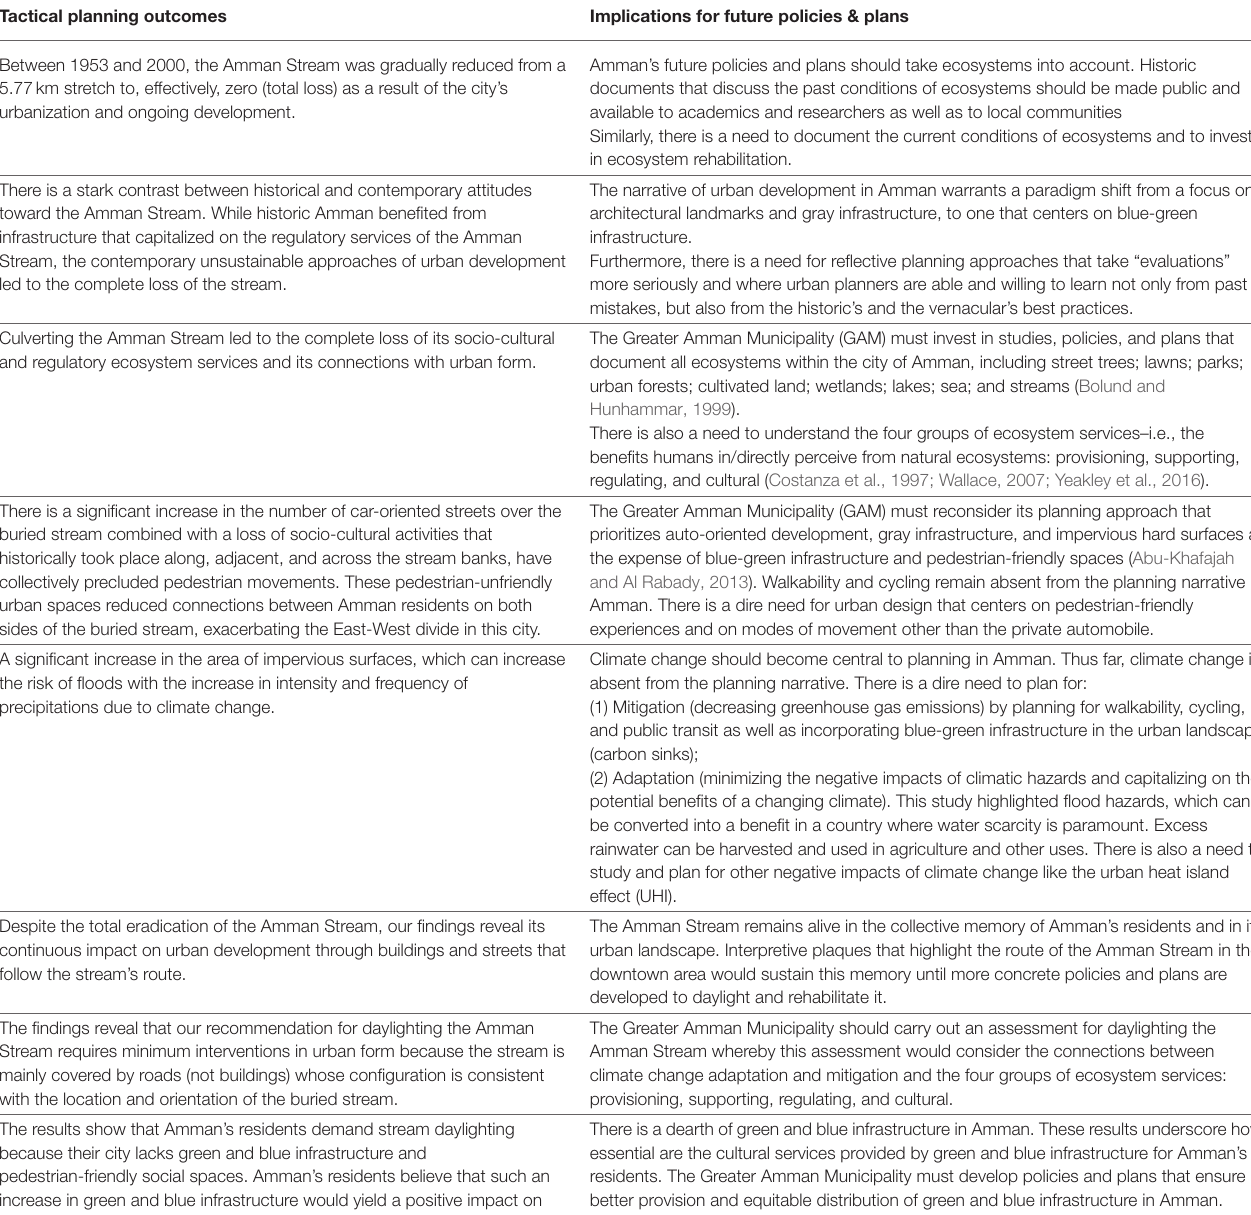
TABLE 2 | A summary of this study’s tactical findings and their implications for policies and plans. Tactical planning